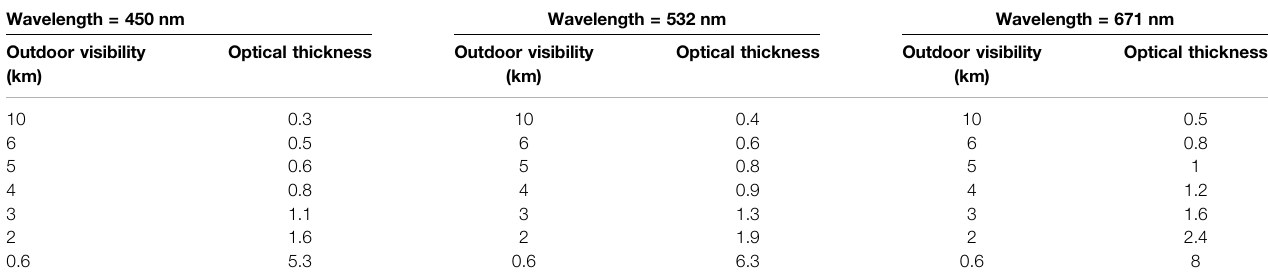
TABLE 1 | Comparison between outdoor visibility and optical